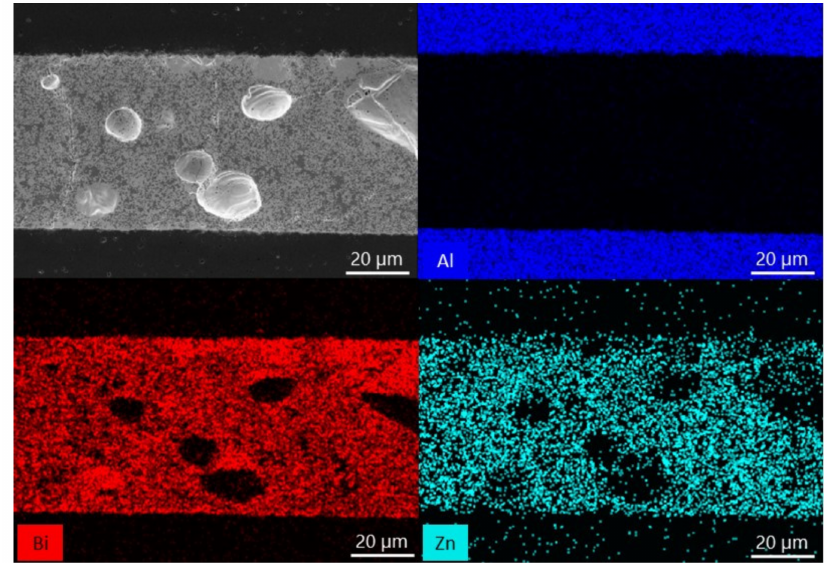
Figure 4. SEM-EDX analysis of the alumina bonded with Bi 2 O 3 -15% ZnO interlayer at 750 ◦